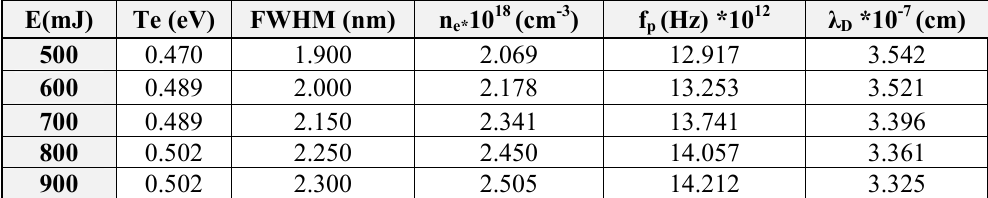
Table 3: Plasma parameters for ZnO: SnO2 at X=0.6 with different laser energies.